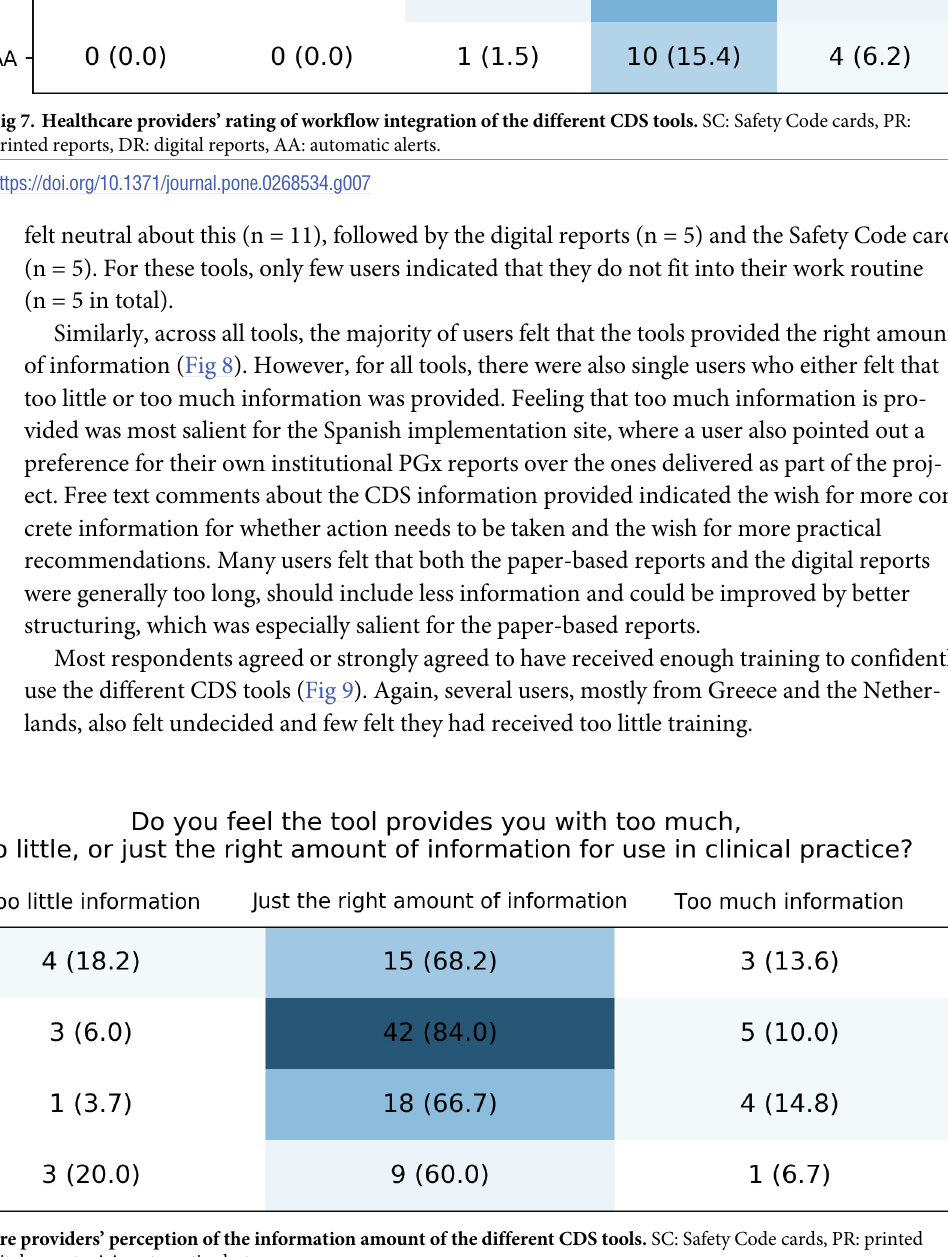
PLOS ONE | https://doi.org/10.1371/journal.pone.0268534 June 8,